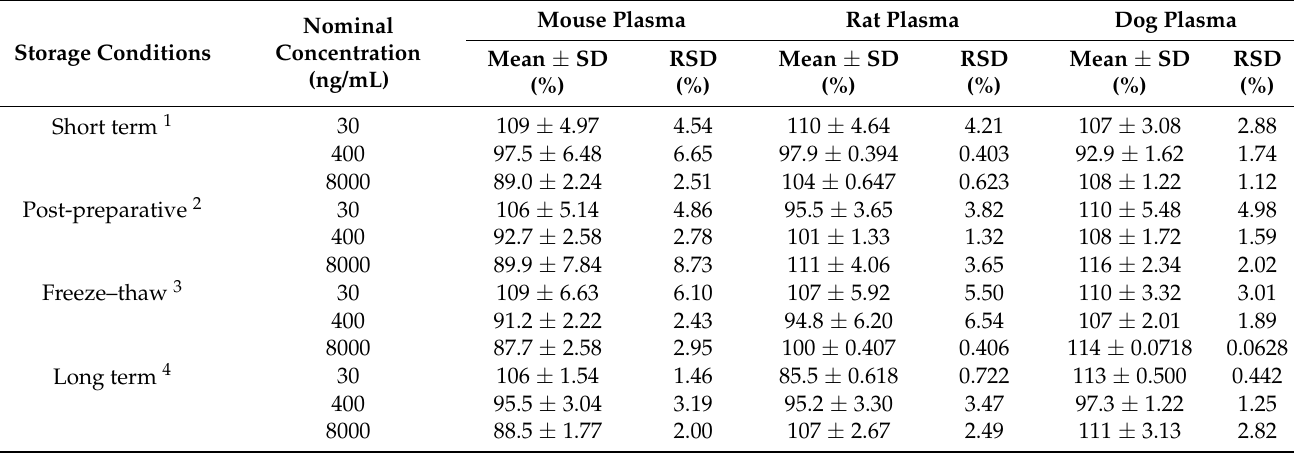
Table 3. Stability (% recovery, n = 3) of DA-7010 in mouse, rat, and dog plasma under various storage conditions.